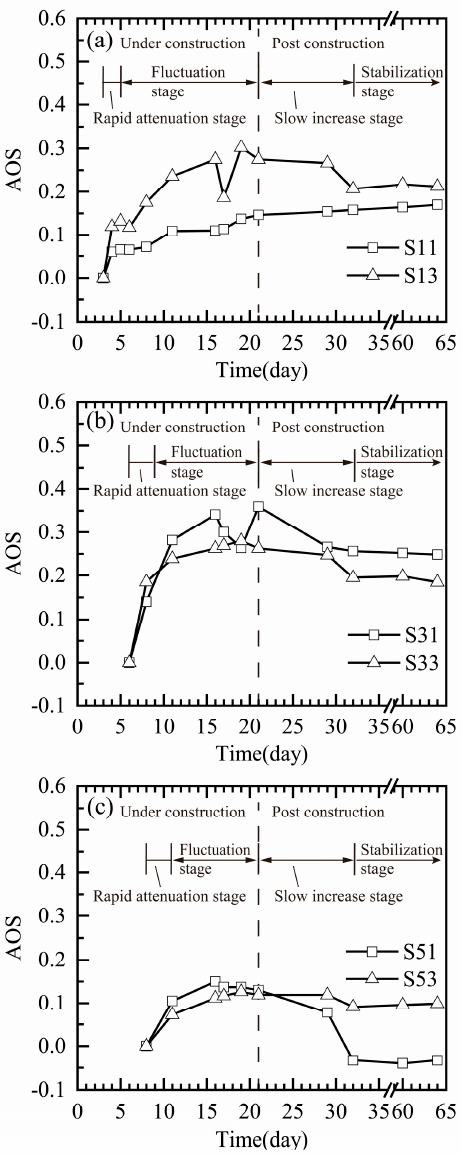
Figure 9. Time series of the structure stress attenuance at two monitoring points: ( a ) Below the surface at 1 m; ( b ) below the surface at 3 m; and ( c ) below the surface at 5 m.